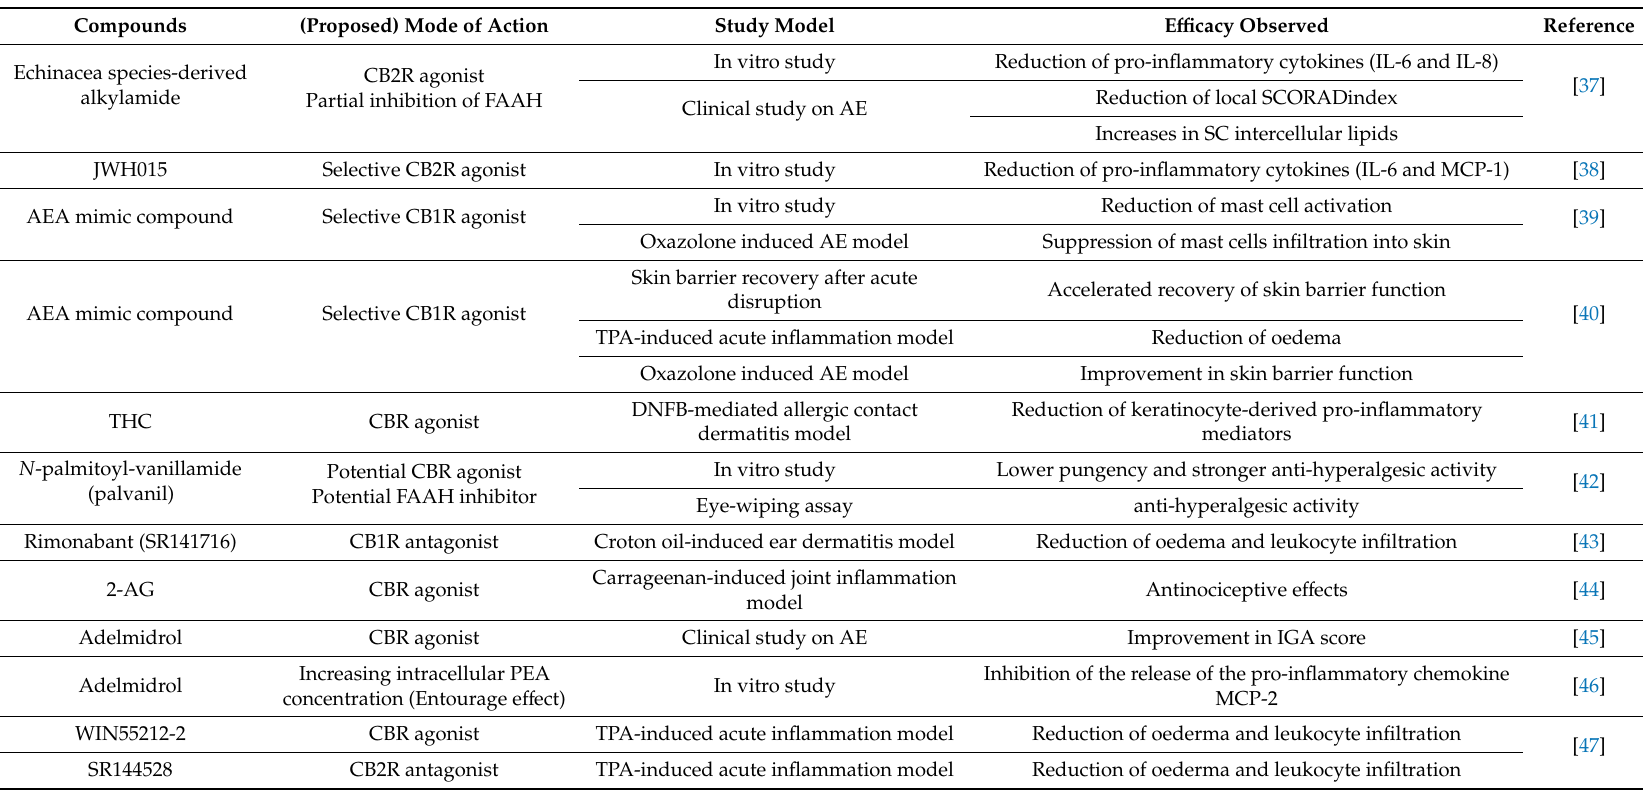
Table 1. Summary of studies about the e ff ects of topical cannabinoid modulating compound (abbreviations: CB1R, CB2R; cannabinoid receptor 1 and cannabinoid receptor 2 respectively; FAAH: fatty acid amide hydrolase; AE: atopic eczema; IL-6: Interleukin-6; SCORAD: SCORing of Atopic Dermatitis; SC: Stratum corneum; MCP-1: monocyte chemoattractant protein-1; AEA: Arachinonoyl ethanolamine; TPA: 12-O-tetradecanoylphorbol-13-acetate; THC: ∆ 9-Tetrahydrocannabinol;